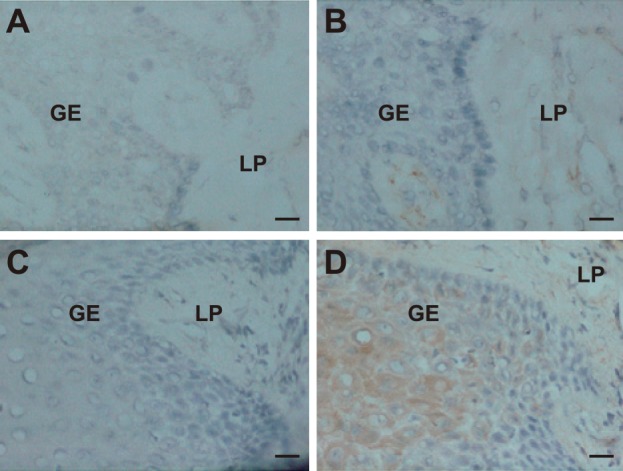
Production of IL-33 is increased in chronic periodontitis.Cryosections of normal periodontal tissues from healthy donors (A and B) and inflamed periodontal tissues from patients with chronic periodontitis (C and D) were stained with rabbit anti-human IL-33 mAb (B and D) or rabbit anti-human IgG isotype control (A and C) and HRP-conjugated anti-rabbit IgG and then visualized with DAB. Sections were counterstained with Mayer’s hematoxylin. GE, gingival epithelium; LP, lamina propria. Bar = 3 μm. Data are representative of five experiments.